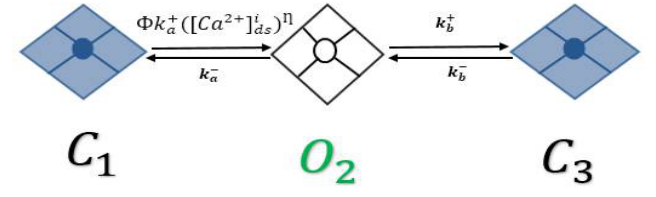
Figure 1. Three-state RyR2 model that produces experimentally constrained Ca 2+ dependence and adaptation.